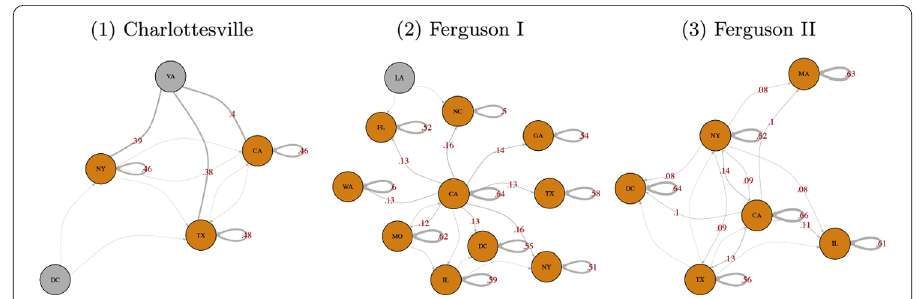
Figure 8 Exploration of local and global contributions to forecasting. While the orange nodes represent the states which are correctly predicted by the corresponding models, the gray nodes denote the states either not correctly predicted or where no events occurred, yet still contribute to forecasting events in the correctly predicted states with a value above a certain threshold. The edges indicate the contribution to